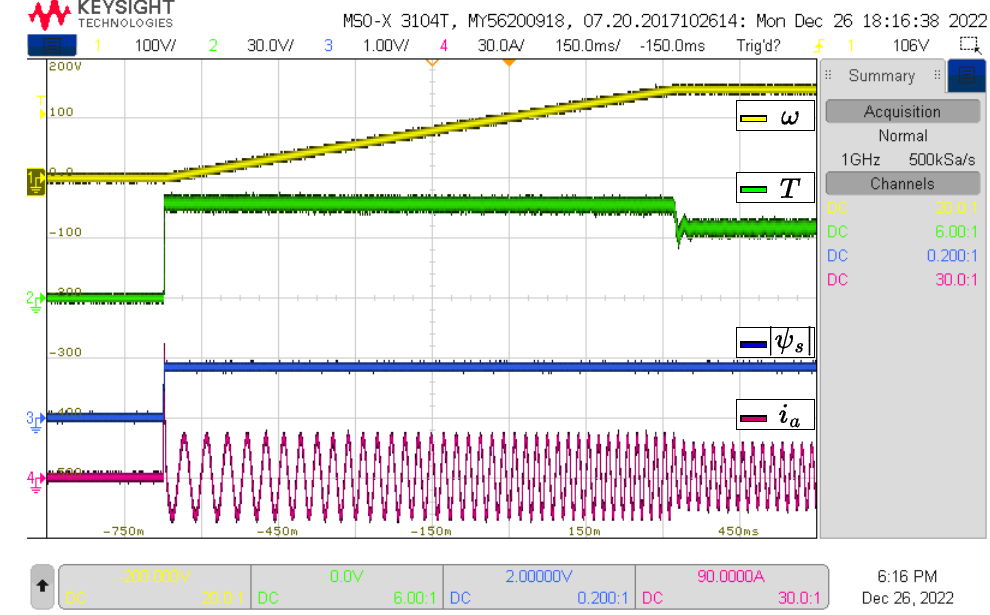
Figure 11. HIL Results for VSI with N =